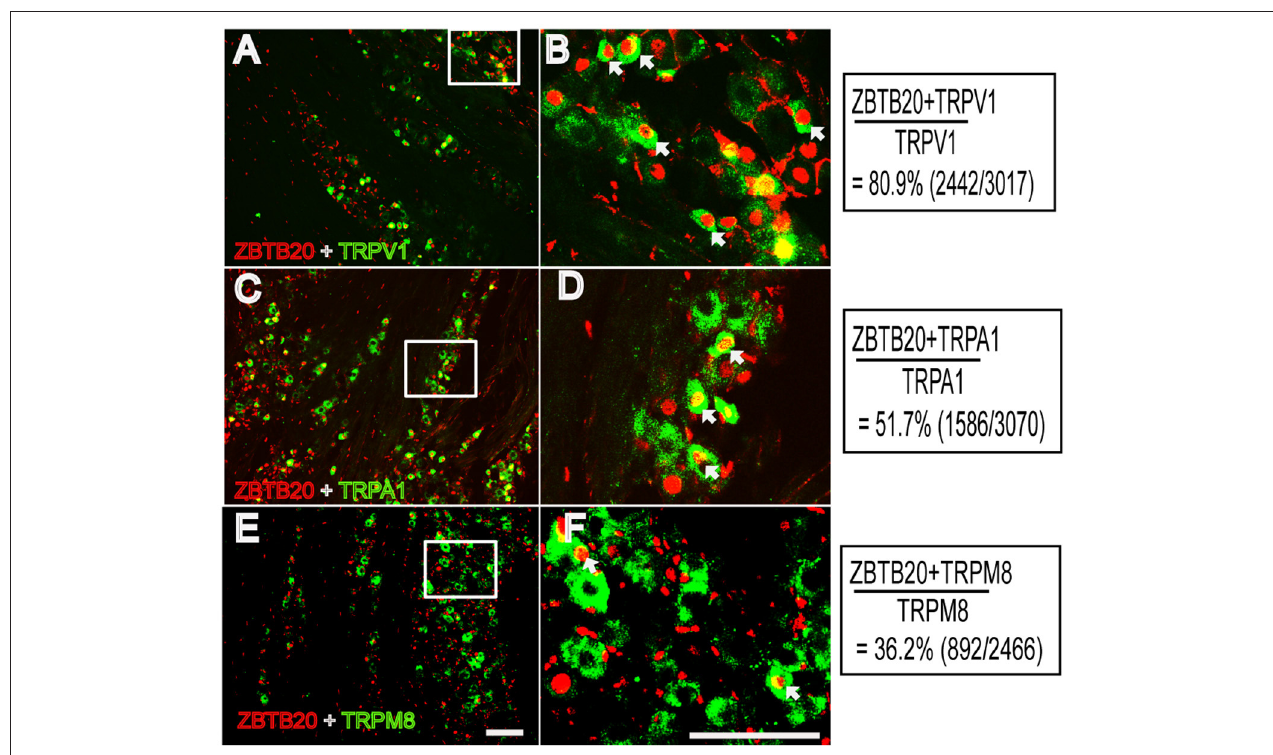
FIGURE 5 | Colocalization of ZBTB20 with TRPV1, TPRA1, and TRPM8 in the trigeminal ganglia (A,B) Colocalization of ZBTB20 with TRPV1. (C,D) Colocalization of ZBTB20 with TRPA1. (E,F) Colocalization of ZBTB20 with TRPM8. Figures B,D,F are high magnifications of the boxes in Figures A,C,E . The arrowhead indicates the colocalization of ZBTB20 with TRPV1, TRPA1, and TRPM8 in Figures B,D,F . N = 3; bar = 50 µ